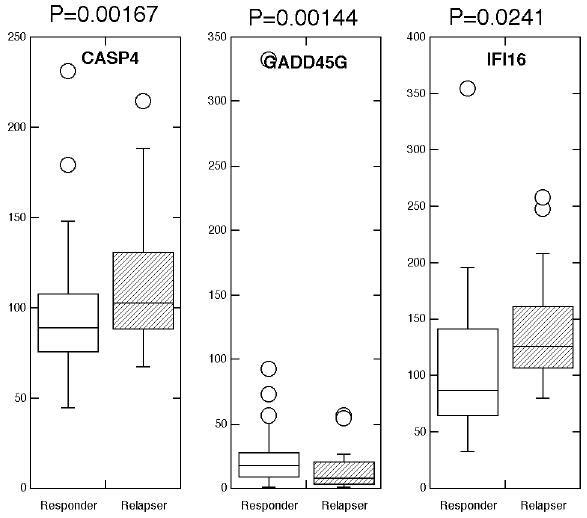
Figure 2. Differential expression of an IFN-regulated signature geneset in relapsers versus responders to IFN-ribavirin therapy to therapy. Expression of an IFN signature geneset was determined in RNA extracted from FFPE liver biopsies by nCounter analysis. Boxplots of genes found to be statistically differentially expressed by nonpara- metric Mann-Whitney analysis (p , 0.05).